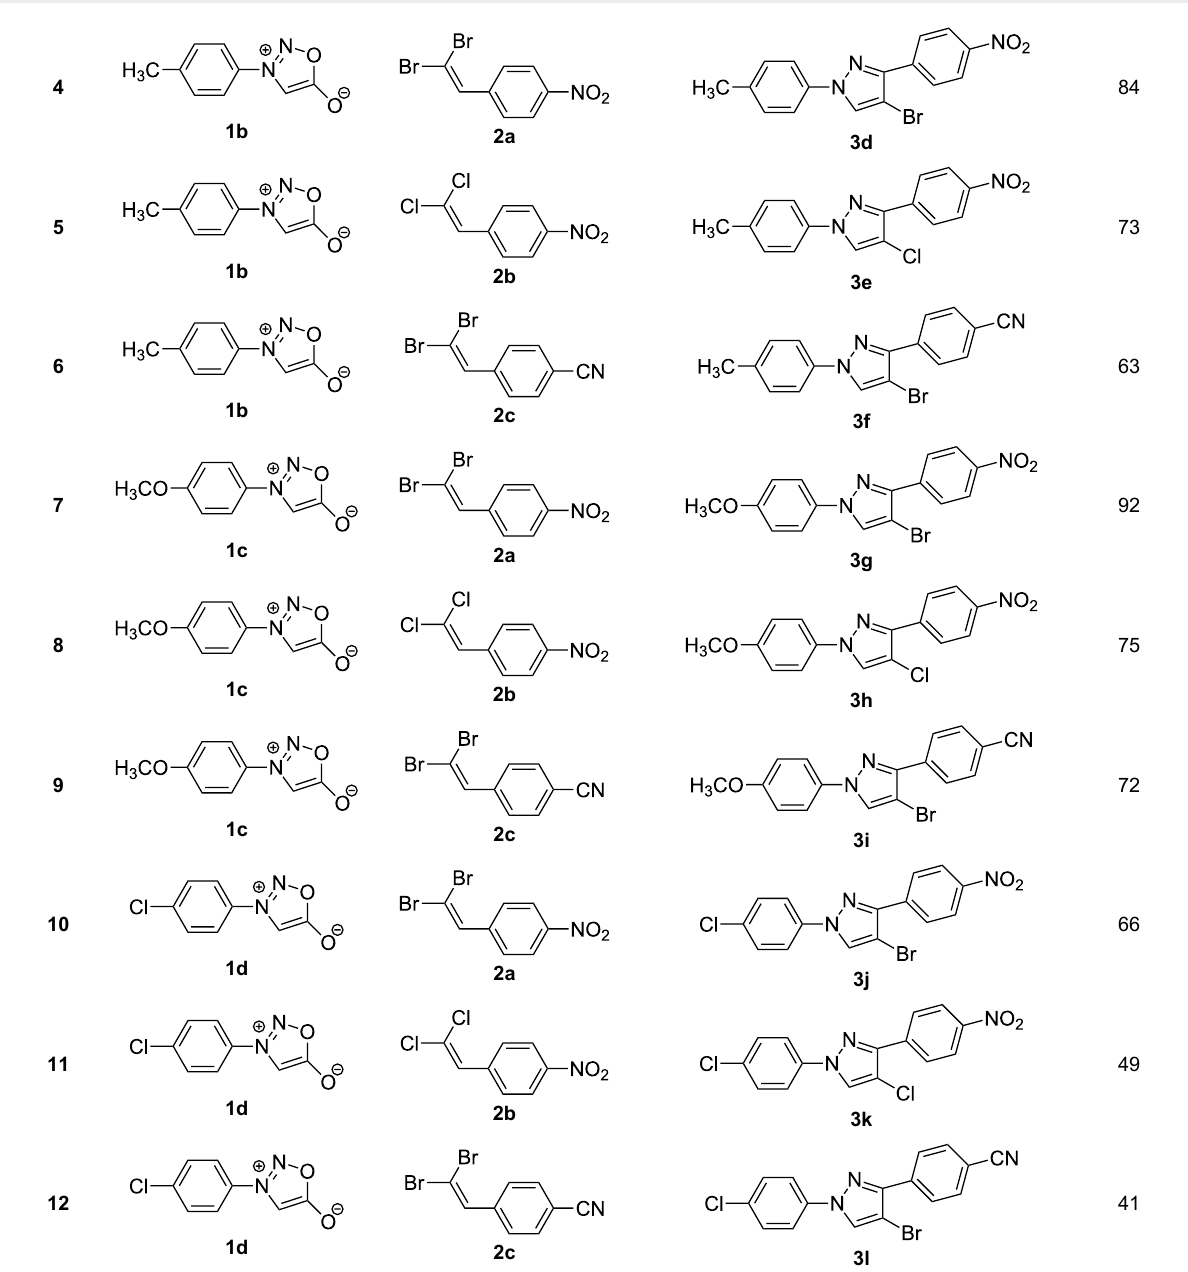
Table 2: Synthesis of 1,3-diaryl-4-halo-1 H -pyrazoles 3 . a